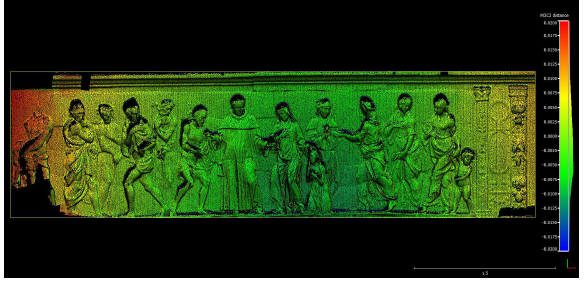
Figure 8. Comparison between the (reference) scan data and the photogrammetric dense cloud – GCPs are only used for referencing the model – Step 1